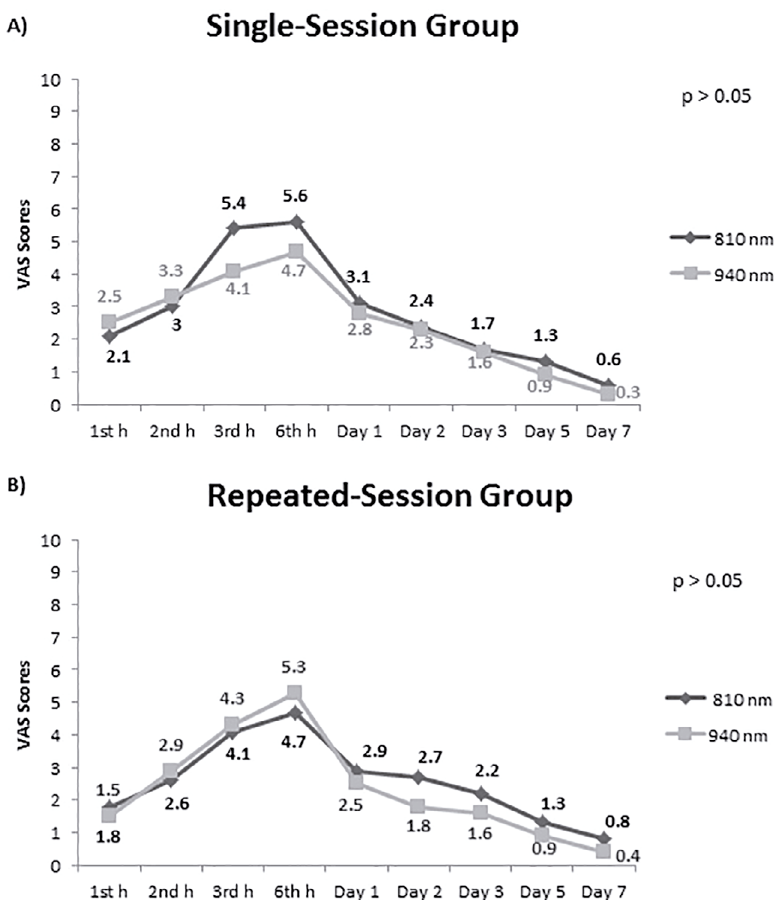
Figure 2- Comparison of the 810 nm and 940 nm groups in terms of pain severity at measuring time points in single-session and repeated session laser